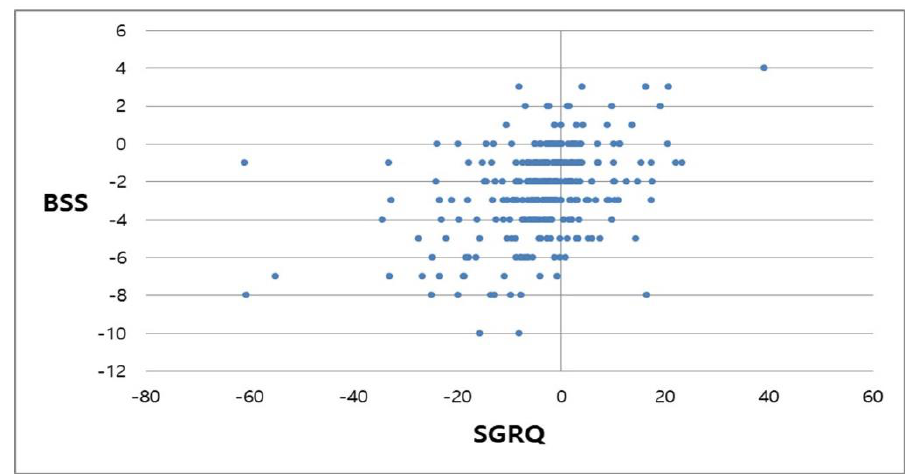
Figure 4. Scatter plot of variation between SGRQ (St. George`s Respiratory Questionnaire) and BSS (Bronchitis Severity Score).